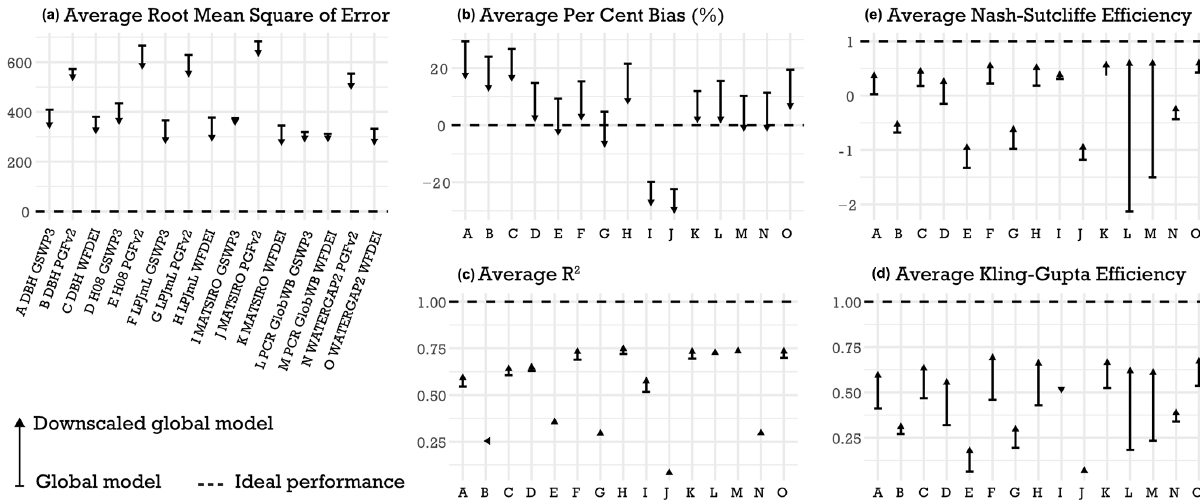
Figure 4. Comparison of the performance of GHMs and downscaled GHMs averaged over all 10 monitoring stations.